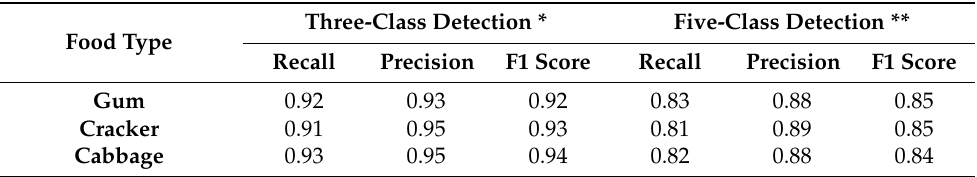
Table 6. The detection performance of chewing side by food type (closed food, hybrid CTC/attention model, and 10 × data augmentation).